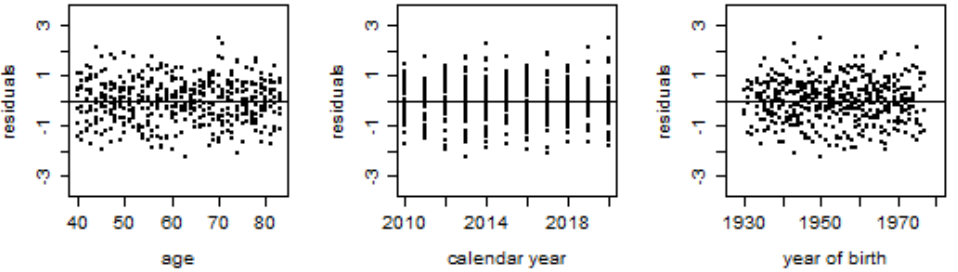
Figure 8. RH Deviance Residuals from the Fitted Model to the Ghana Pension Population for Ages 40–83 and the Period